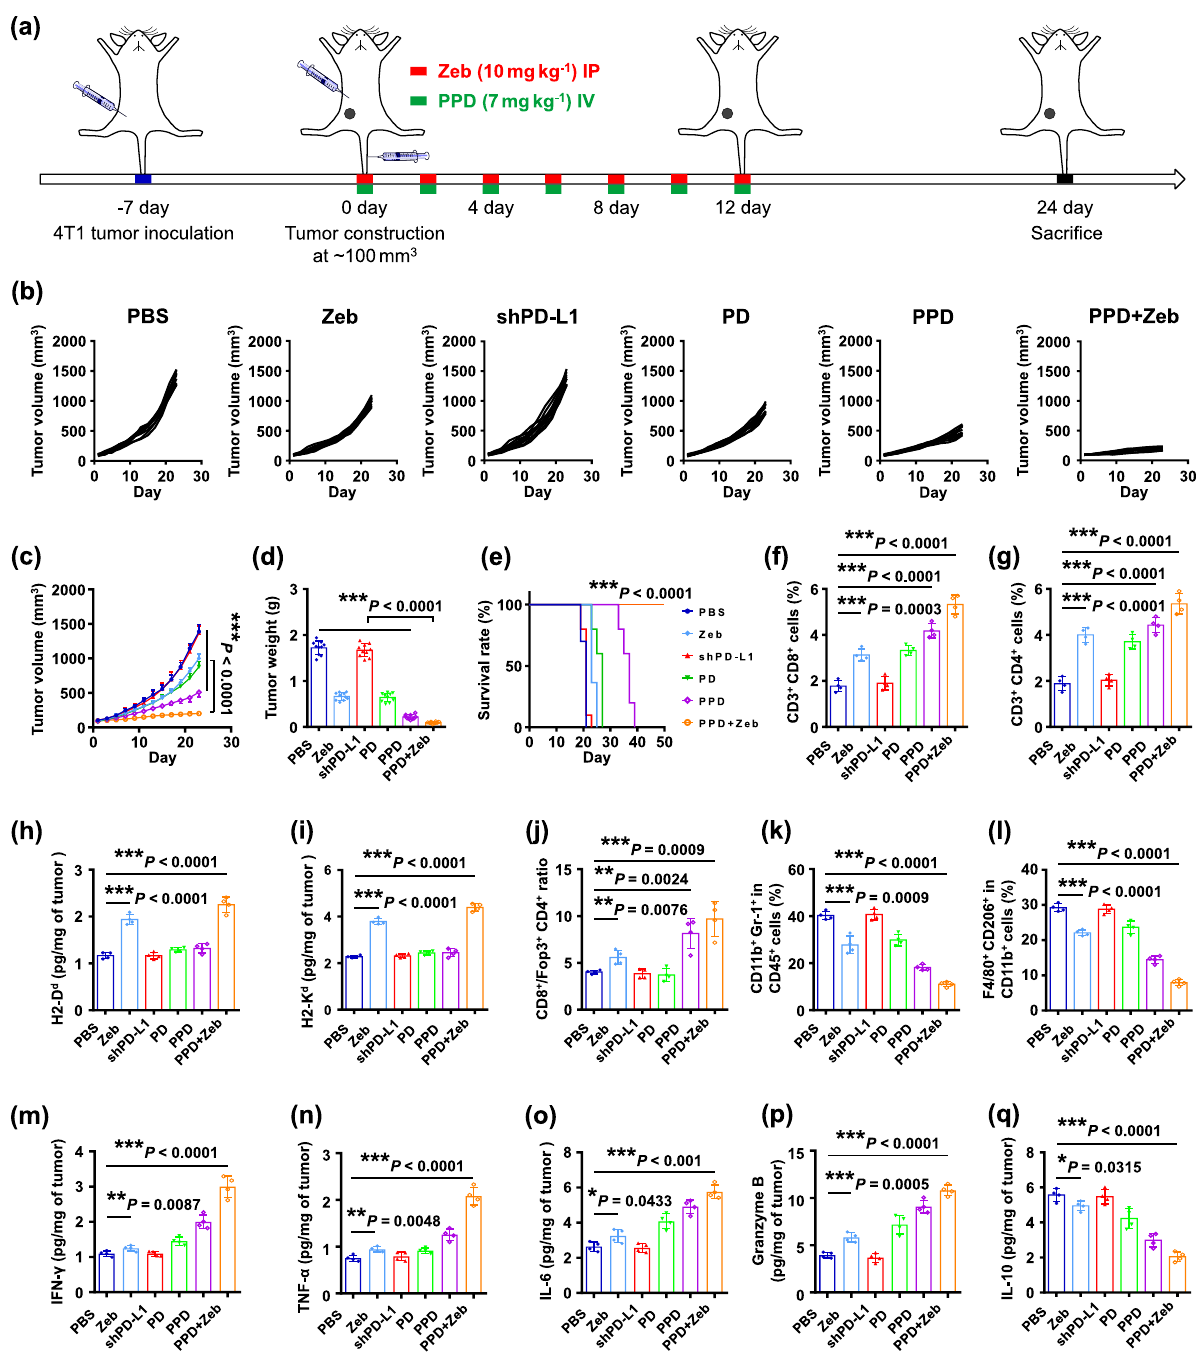
Fig. 6 PPD combined with Zeb induced systemic anti-tumour immune response and inhibited 4T1 tumour growth. a Therapeutic schedule for PPD plus Zeb-mediated inhibition of 4T1 tumour growth. b Individual and c average tumour growth kinetics in 4T1 tumour-bearing mice receiving different treatments. d Average tumour weight in 4T1 tumour-bearing mice receiving different treatments. e Survival time of 4T1 tumour-bearing mice receiving different treatments as indicated. When the tumour volume of tumour-bearing mice arrived at 1000 mm 3 , the mice was de fi ned as dead. f Percentages of CD3 + CD8 + T cells gating on CD45 + cells in tumours of 4T1 tumour-bearing mice receiving different treatments. g Percentages of CD3 + CD4 + T cells gating on CD45 + cells in tumours of 4T1 tumour-bearing mice receiving different treatments. Levels of MHC I molecules including h H2-D d and i H2-K d in tumours of 4T1 tumour-bearing mice receiving different treatments. j Ratios of CD8 + T/Foxp3 + CD4 + T in tumours of 4T1 tumour-bearing mice receiving different treatments. k Relative quanti fi cation of CD11b + Gr-1 + cells gating on CD45 + cells in tumours of 4T1 tumour-bearing mice receiving different treatments. l Relative quanti fi cation of CD206 + F4/80 + cells gating on CD11b + cells in tumours of 4T1 tumour-bearing mice receiving different treatments. Levels of cytokine including m IFN- γ , n TNF- α , o Granzyme B, p IL-10, and q TGF- β in tumours of 4T1 tumour-bearing mice receiving different treatments. Data in c – q are presented as mean ± SD, n = 10 biologically independent samples in c – e , n = 4 biologically independent samples in f – q . P -values are calculated by the two-tailed Student ’ s t -test in c – q as indicated in the fi gures. * P < 0.05, ** P < 0.01, and *** P < 0.001.